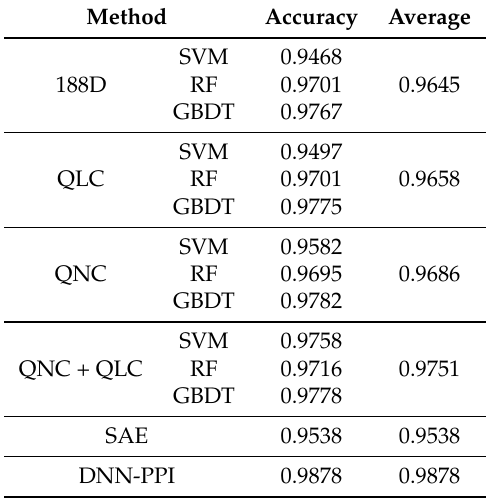
Table 7. Performance comparisons on the hold-out test